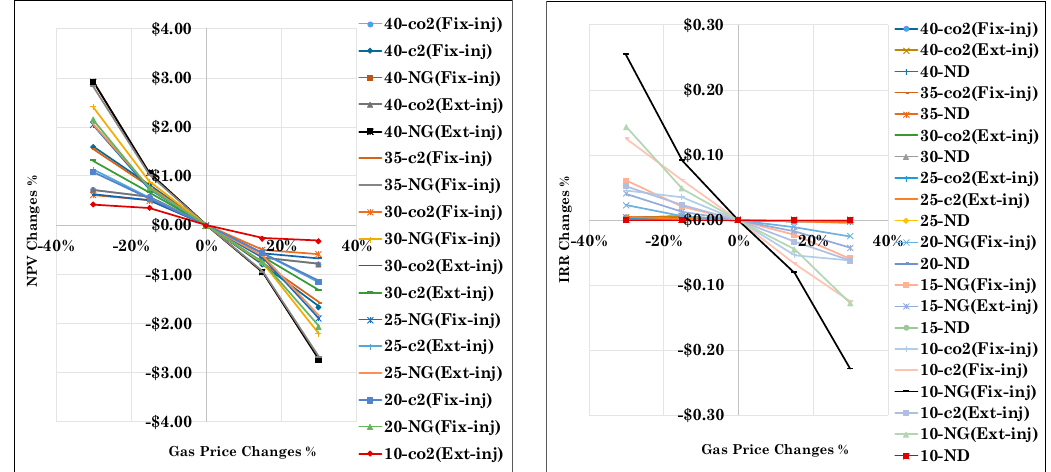
Figure 32. Changes in NPV and IRR coming from variation in Gas Price.